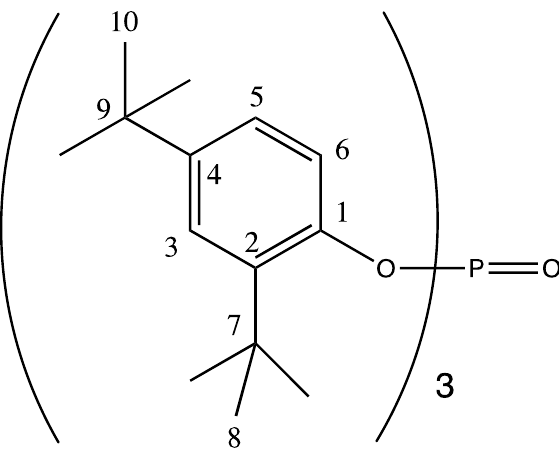
Figure 7. Structure of the identified compound. NMR data: 1 H NMR (CDCl 3 , 600 MHz, 300 K) δ: 1.28 (bs, 27H, H-10), 1.33 (s, 27H, H-8), 7.12 (dd, 3H, J = 2.5/8.6 Hz, H-5), 7.36 (dd, 3H, J = 1.9/2.5 Hz H-3), 7.53 (dd, 3H, 4 J 1H,31P = 0.8Hz; 3 J H,H = 8.6 Hz, H-6. 13 C NMR (CDCl 3 , 150 MHz, 300 K) δ: 30.2 (C-8), 31.5 (C-10), 34.5 (C-9), 34.9 (C-7), 119.1 (d, 3 J 13C, 31P = 2.0 Hz, C-6), 124.0 (C-5), 124.5 (C-3), 138.5 (d, 3 J 13C, 31P = 9.0 Hz, C-2), 147.1 (C-4), 147.7 (d, 2 J 13C, 31P = 6.6 Hz, C-1).Organophosphates are well known for